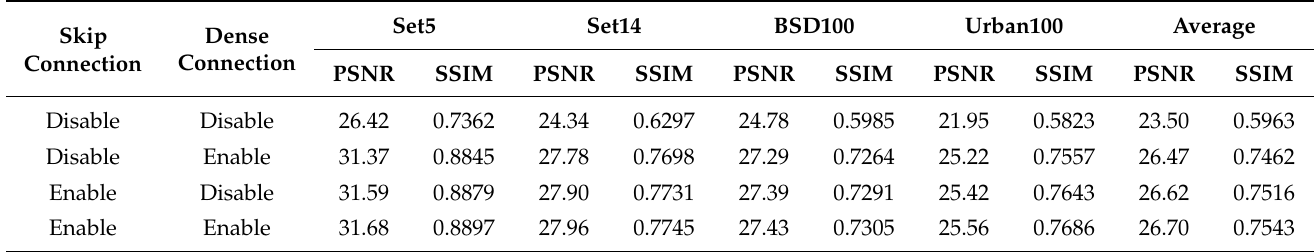
Table 10. SR performances according to tool-off tests.